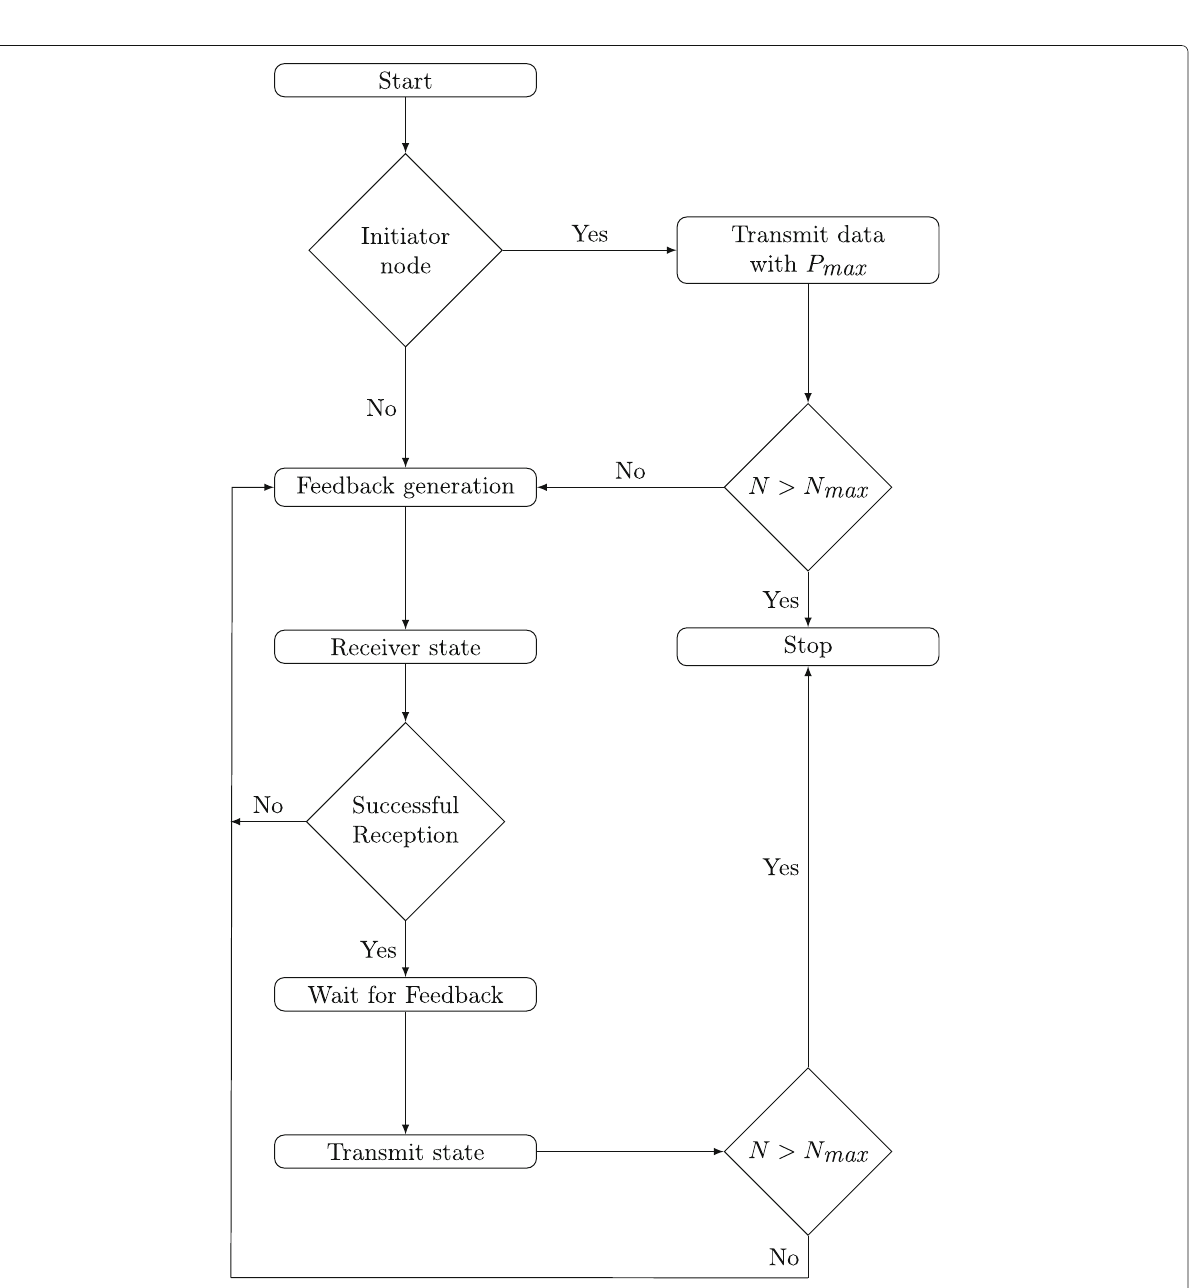
efficiency such as outage probability and feedback